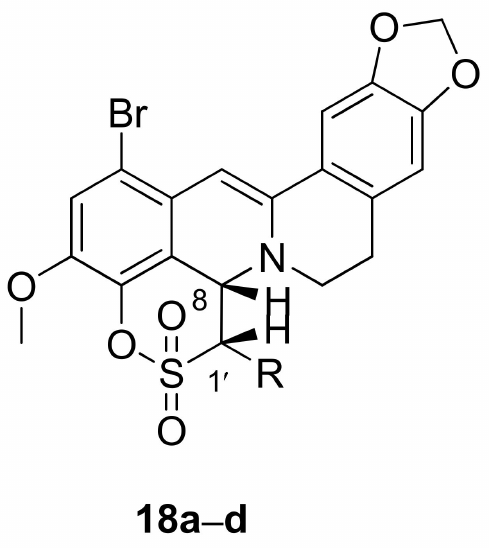
Figure 6. Structure of compounds 18a – d .